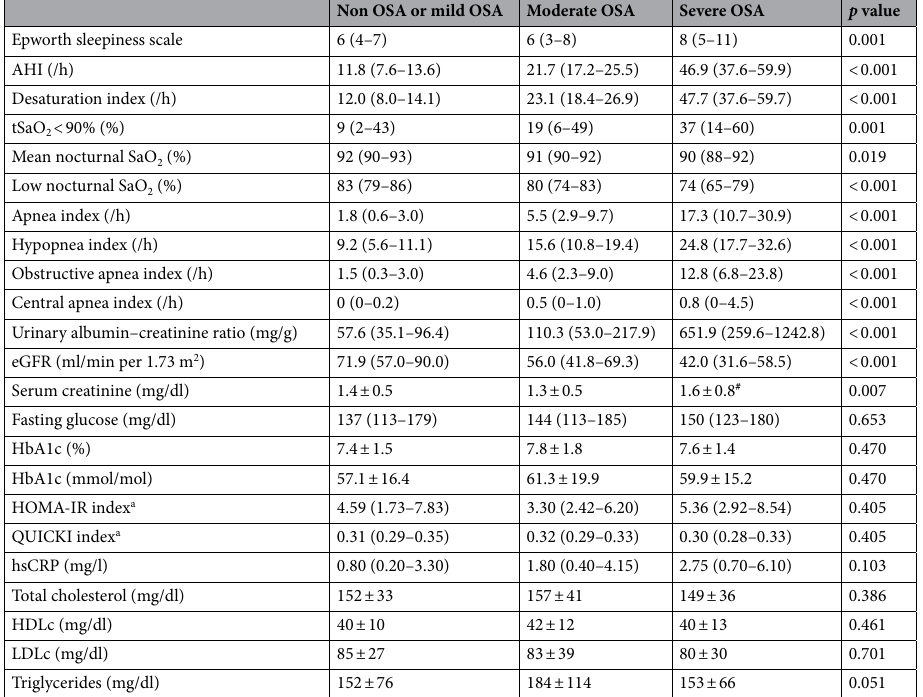
Table 2. Comparison of sleep characteristic and biochemical parameters between the OSA subgroups. Values are median (interquartile range [IQR]) or mean ± SD, according their distribution. Comparisons were performed by Kruskal–Wallis test or ANOVA with post-hoc comparisons by Bonferroni test: # p < 0.01 vs. moderate OSA. AHI apnea–hypopnea index, tSaO 2 percentage of recording time with oxygen saturation < 90%,